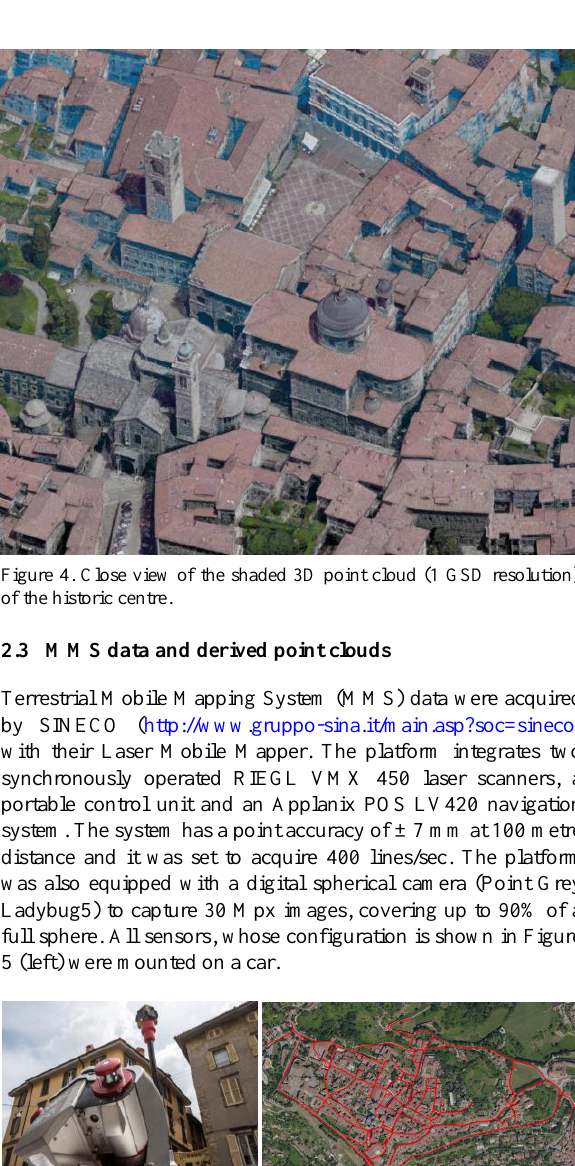
(Figure 6), corresponding to a mean spatial resolution of 1-2 cm on the road plan and on the facades adjacent to the